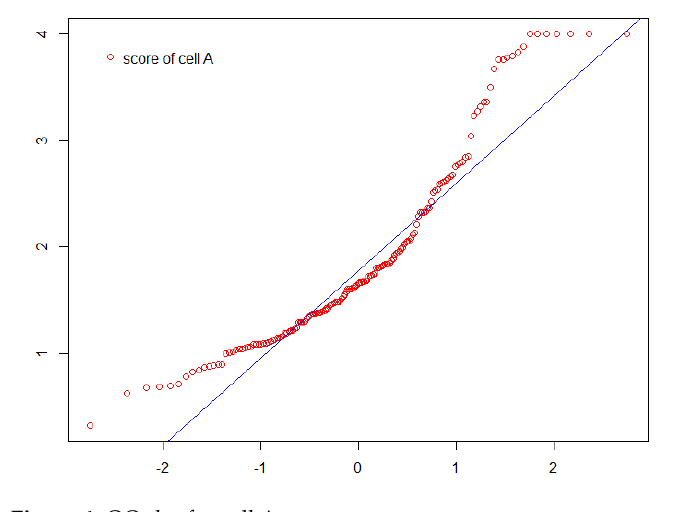
Figure 4. QQplot for cell A.